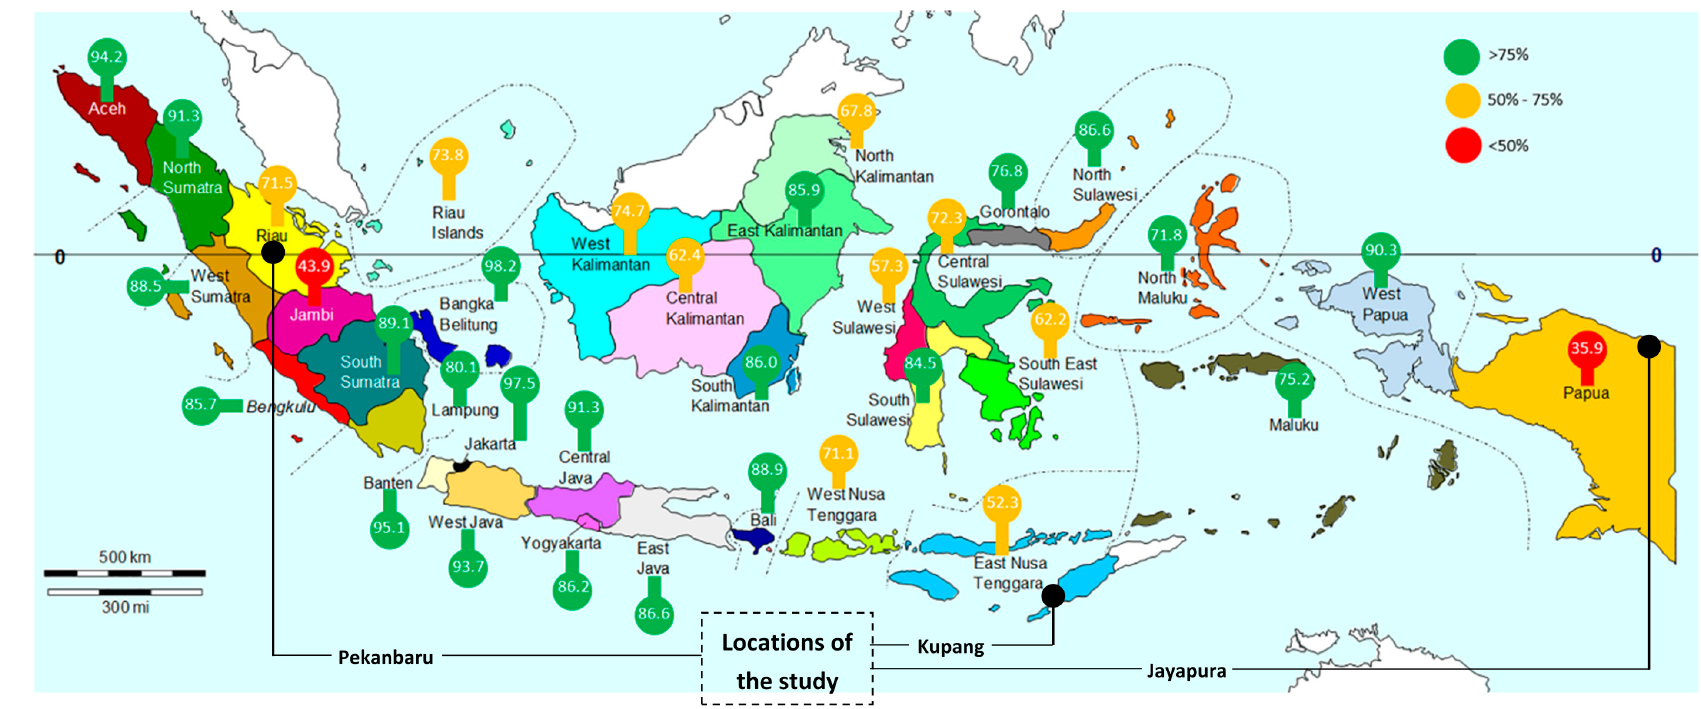
Figure 1. Map of Indonesia showing ERs for 34 provinces in 2015. Data is based on Perusahaan Listrik Negara (PLN) (2016) [2], and the map is based on Dalet (2007) [10].